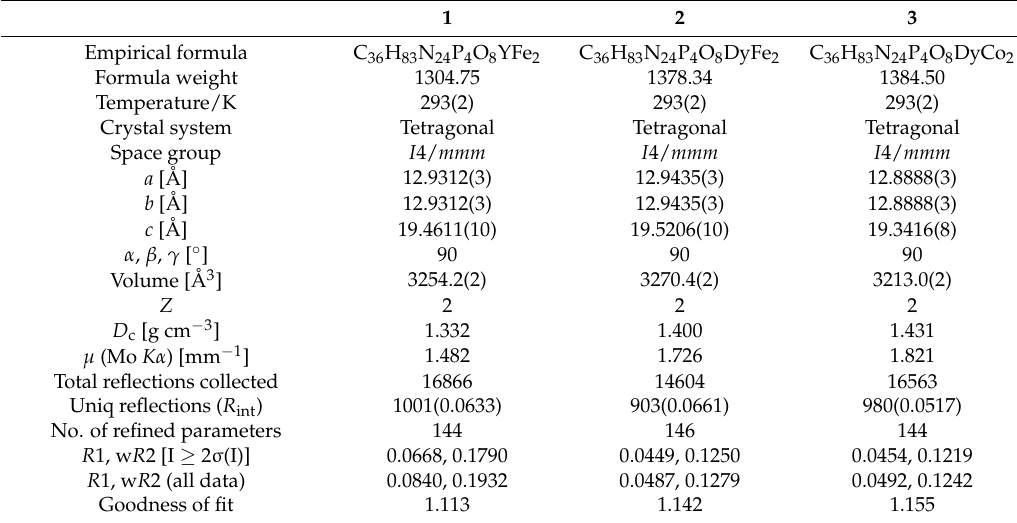
Table 1. Crystallographic data for the compounds 1 – 3